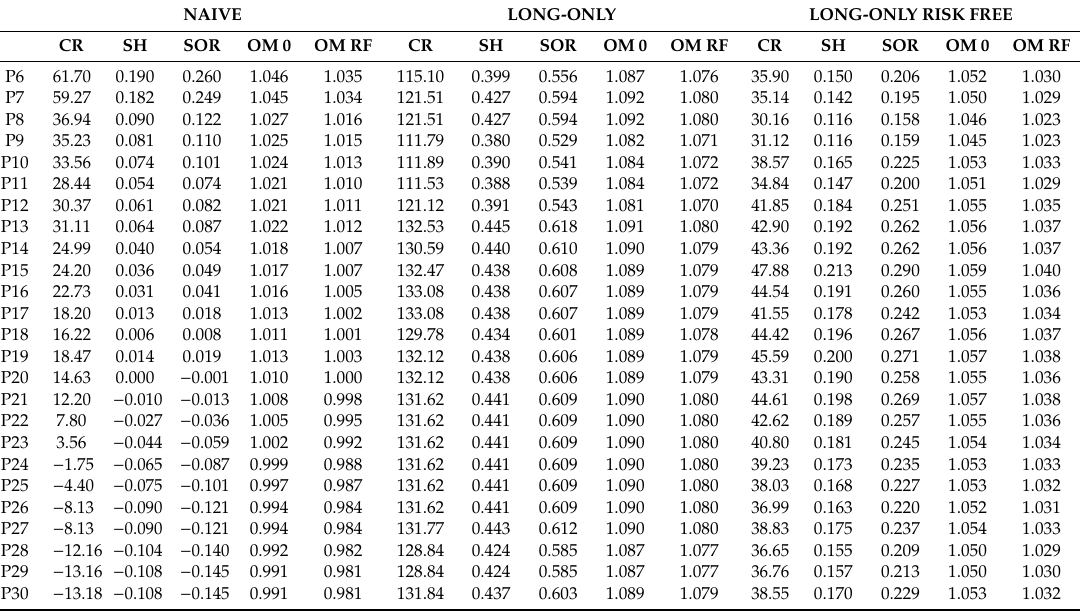
Table 8. Performance from responsible portfolios using a 5-year rolling window considering transaction